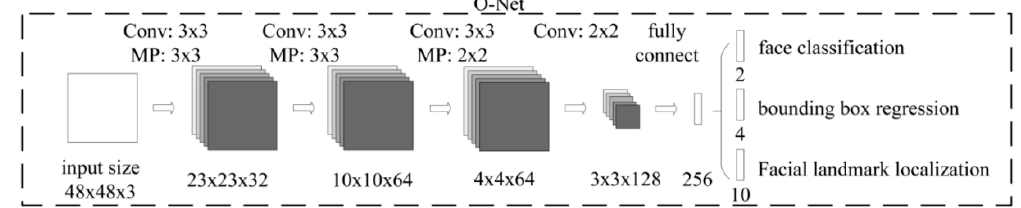
Figure 4. Output Network (O-Net) structure.